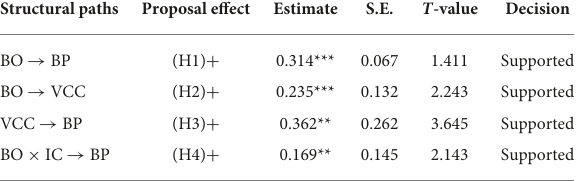
TABLE 2 Structural model results